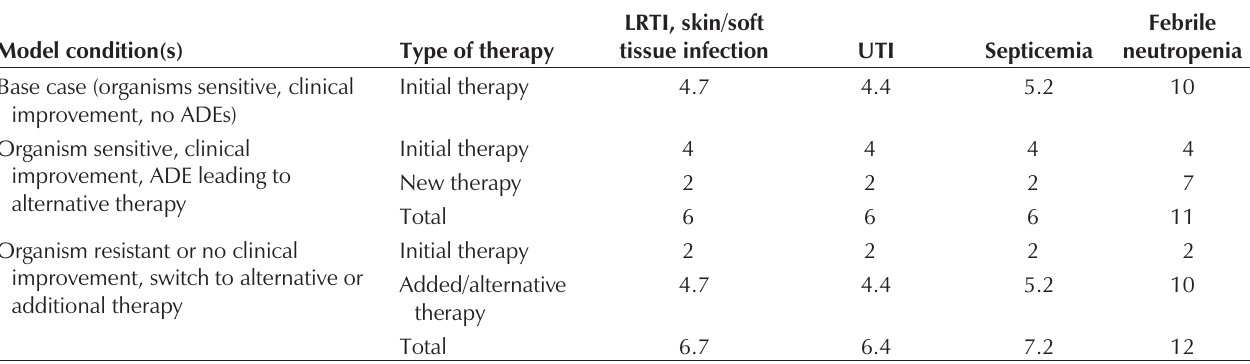
ADE Adverse drug event; LRTI Lower respiratory tract infections; UTI Urinary tract infections